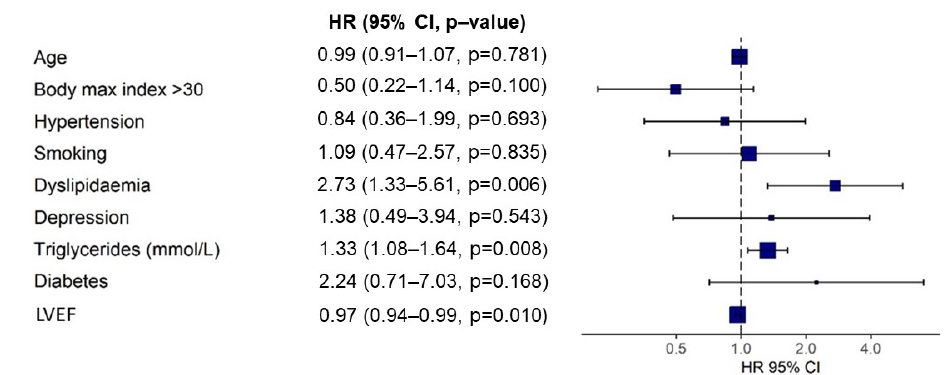
Figure 4. Clinical outcomes of case and control groups at the time of the first MACE .